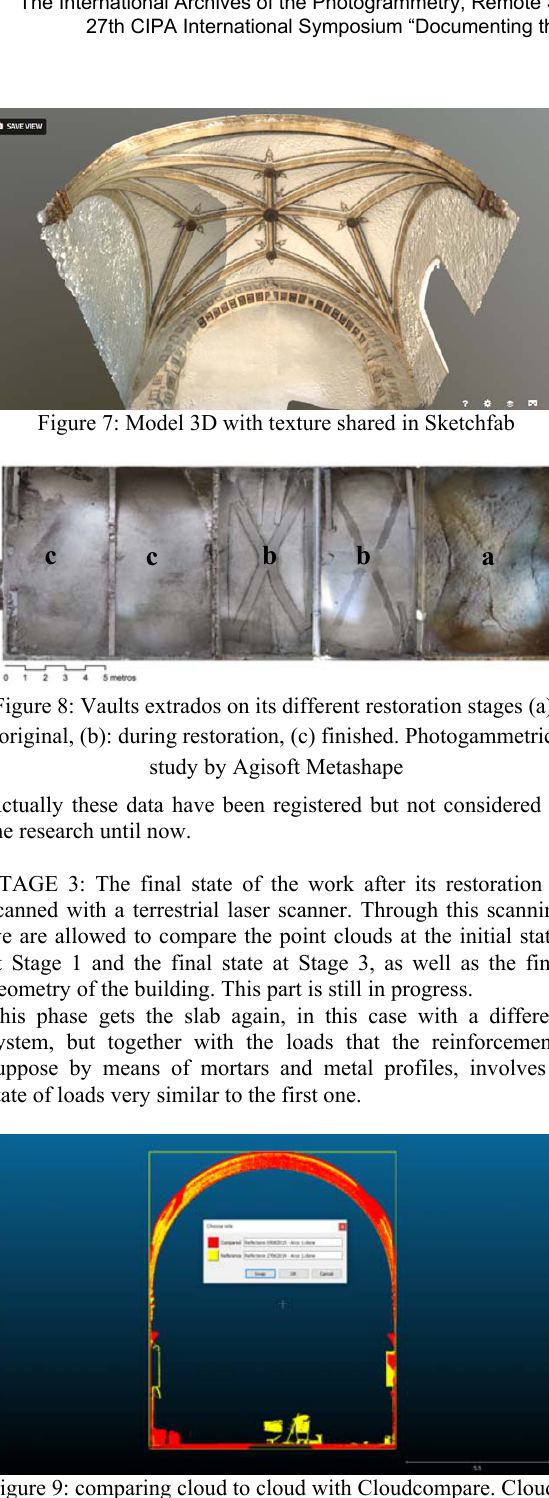
Figure 12: East facade with perceptible